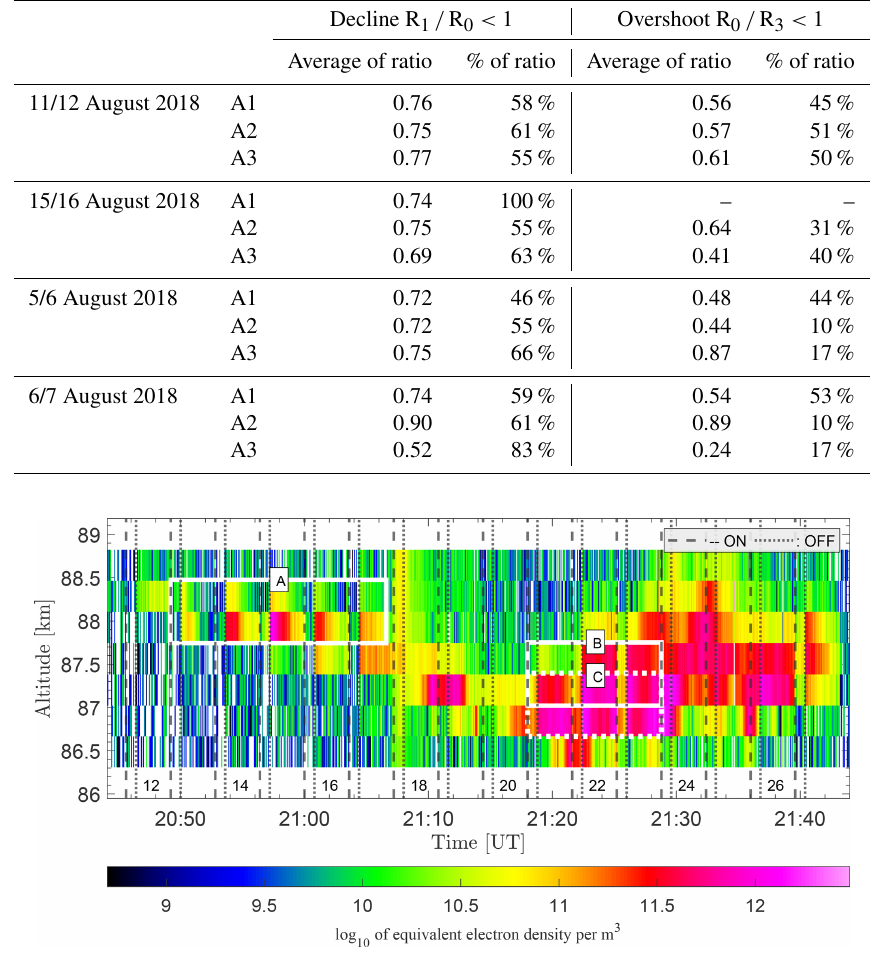
Figure 13. Overview of Area 2 – 15 of August 2018, with interesting visible overshoot cycles marked with intervals A, B, and C. Data resolution is 4.8s. Cycles are marked in the figure (from 12 to 27) as well as their corresponding On/OFF